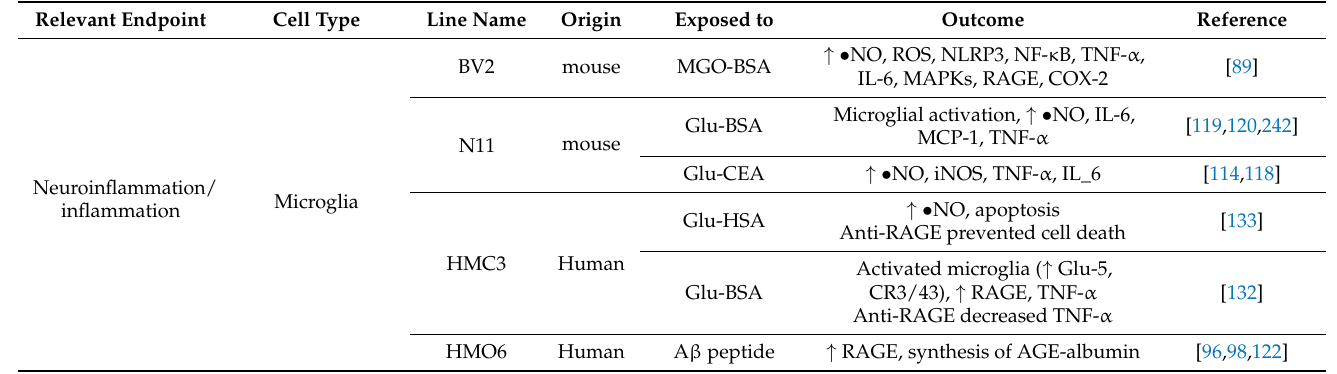
Table 1. Main outcomes from existing studies on AGEs or other RAGE ligands, in which monocultures were used as models of neuroinflammation, neurodegeneration, and